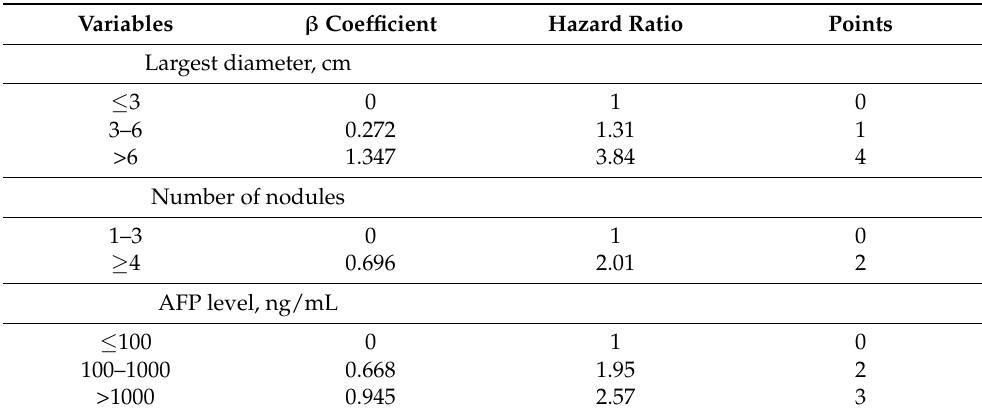
Table 1. Calculation of the AFP ( α - fetoprotein) score. The score is calculated by adding the individual points for each obtained variable. A cut-off value of 2 separates between patients at high and low risk of recurrence